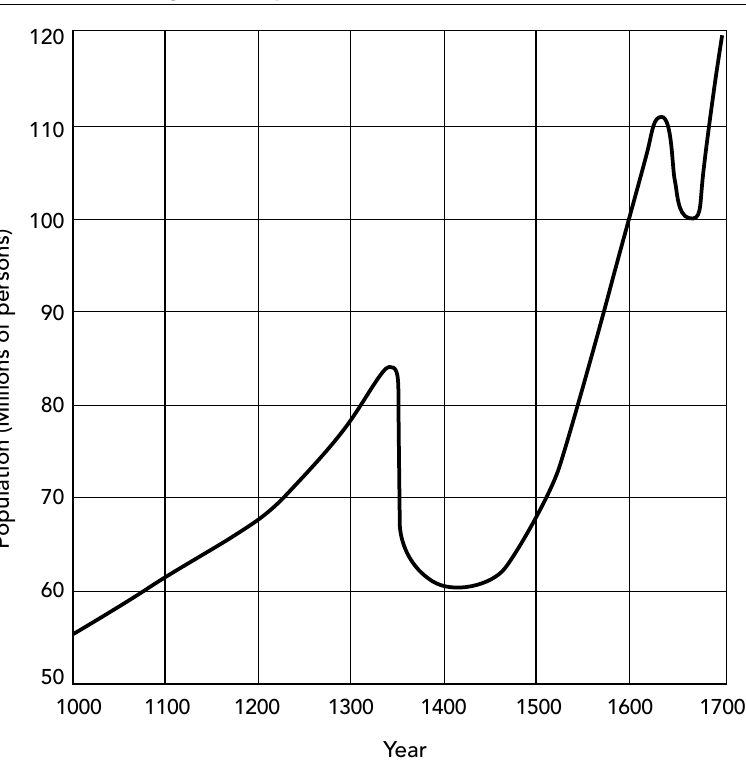
Figure 6 – European Population at the time of the Great Plague (from Langer 1964) While a complex of economic, social and political factors contributed to the Irish catastrophe, the famine can be seen as a case of overshoot-generated